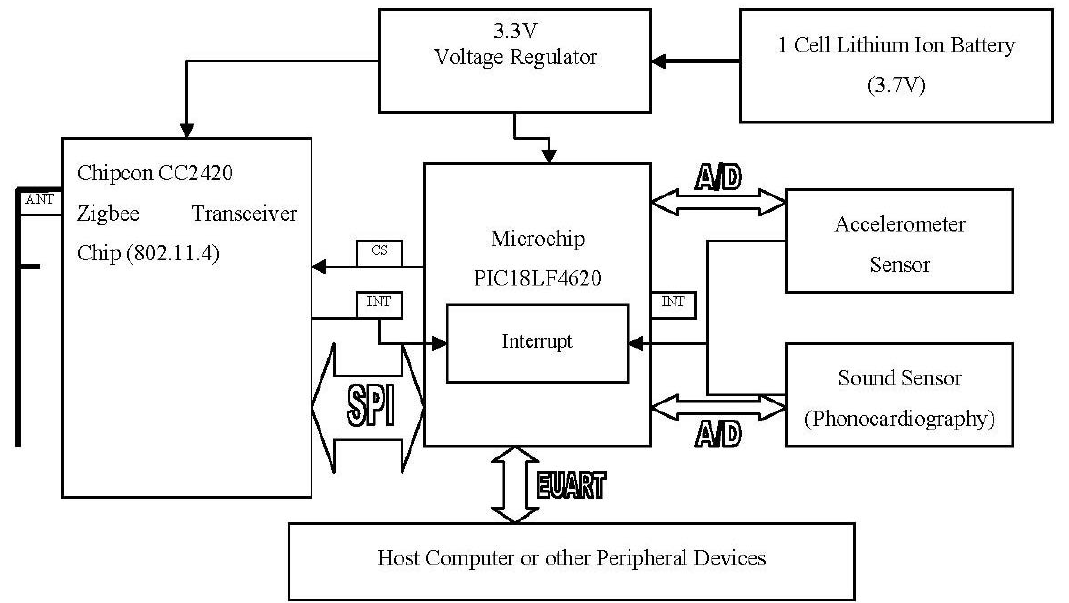
Figure 5. Architecture of Wireless Sensor